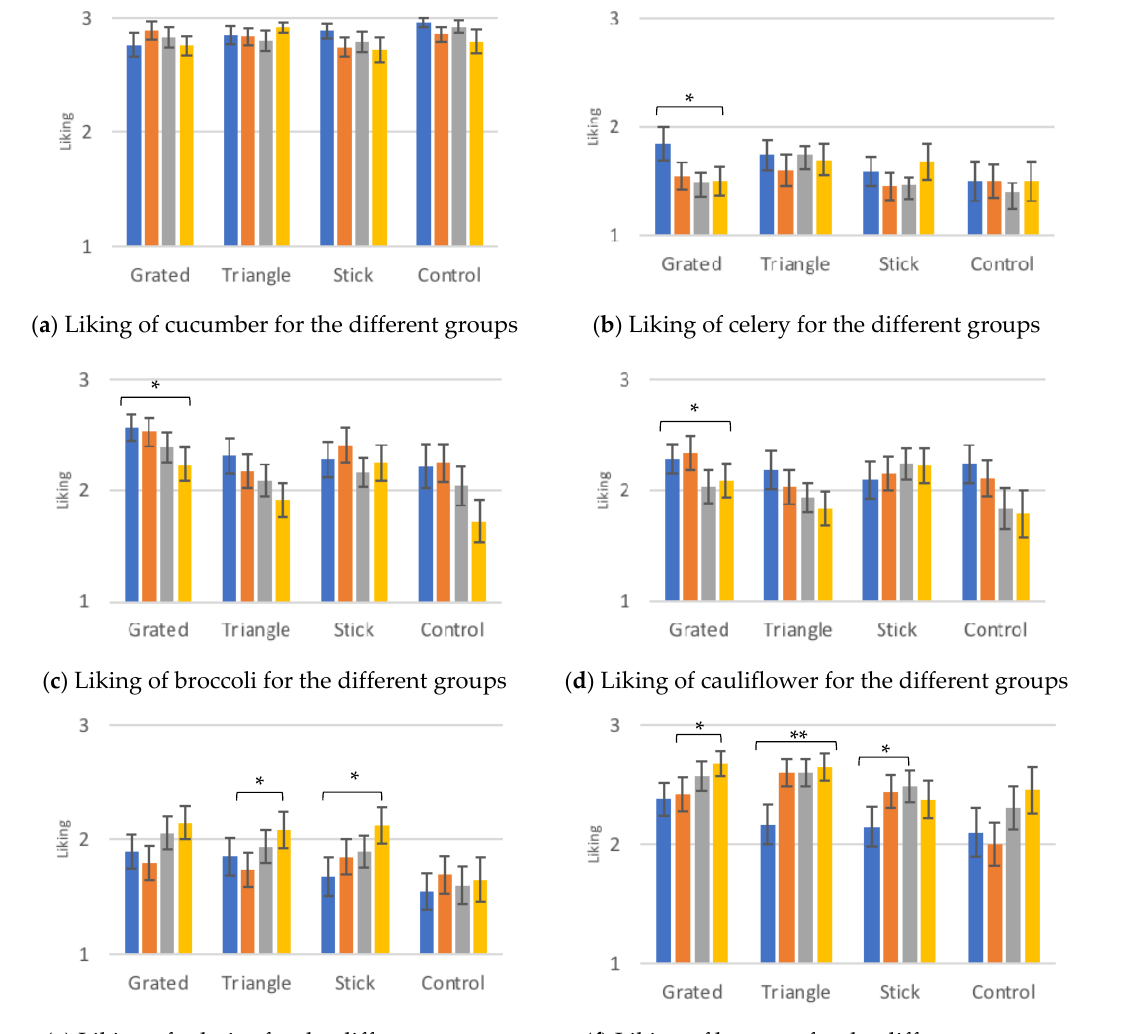
Figure 7. ( a – f ) Liking scores ± SEM of the different vegetables measured in the control sessions for each serving style group in order to investigate the presence of transfer effects. The significance of selected differences only for all the groups are depicted. The detailed differences and their statistical significance are given in text. Significance levels: ** p ≤ 0.01, * p ≤ 0.05.